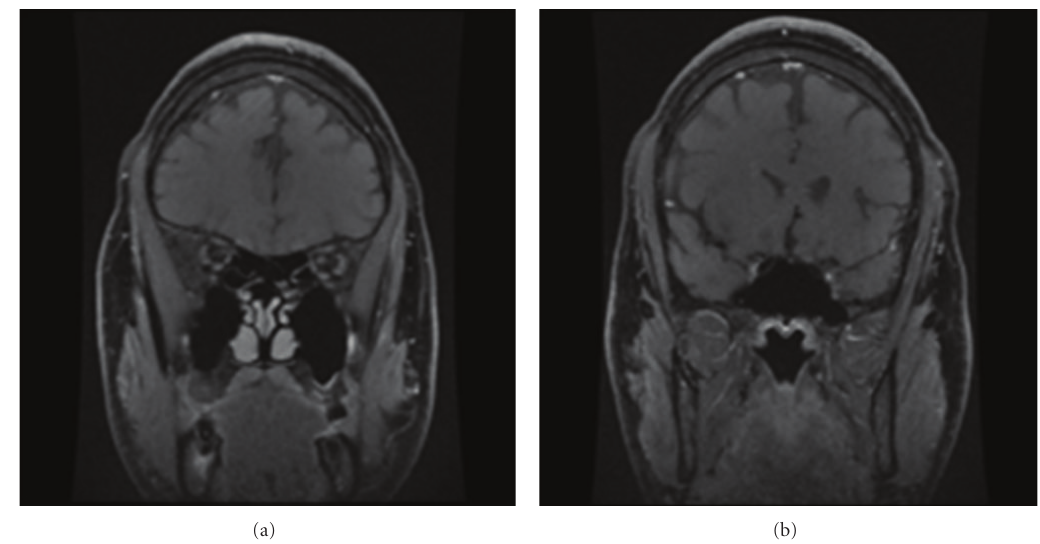
Figure 4: MR imaging of Case 4 showing extensive enhancement of the left optic nerve both intraorbitally (a) and intracranially